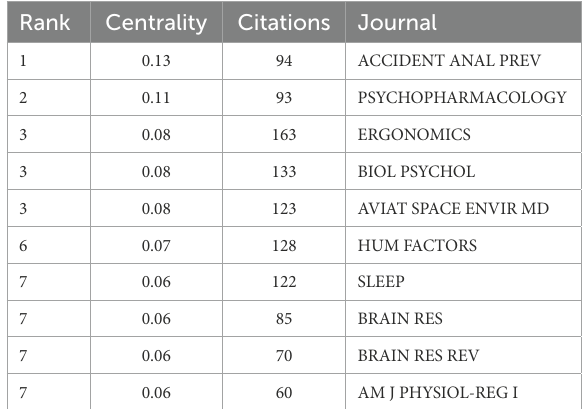
TABLE 4 The top 10 most centrality journals regarding effects of mental fatigue on athletic performance.